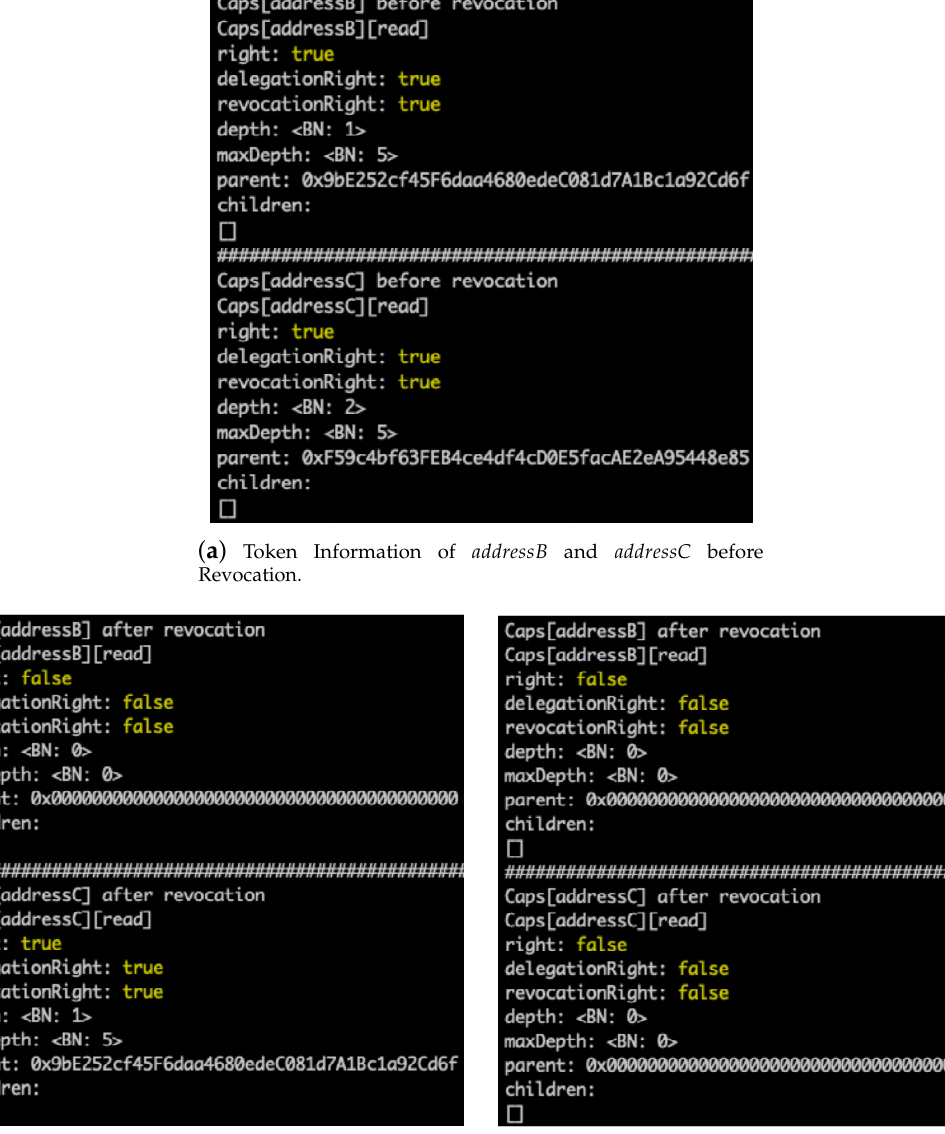
Figure 8. Revocation of read